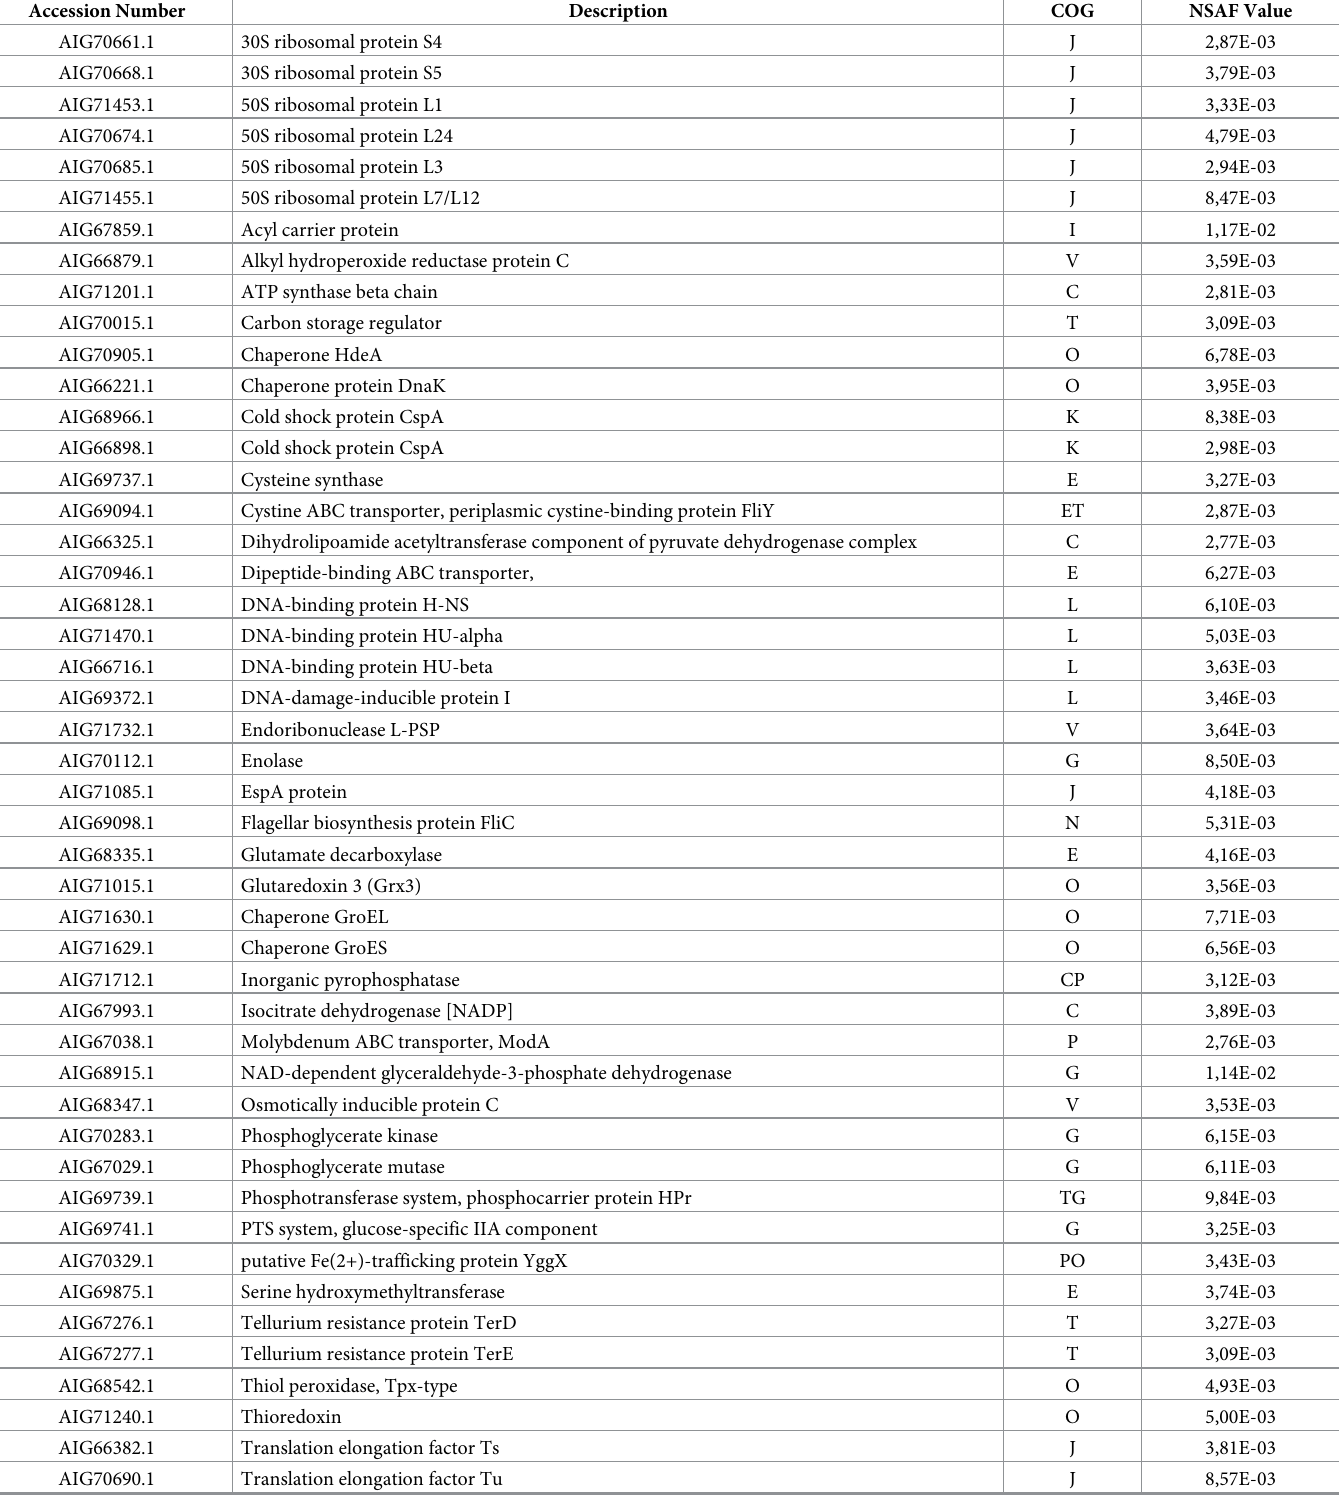
Table 1. List of the most abundant proteins of EHEC O157:H7